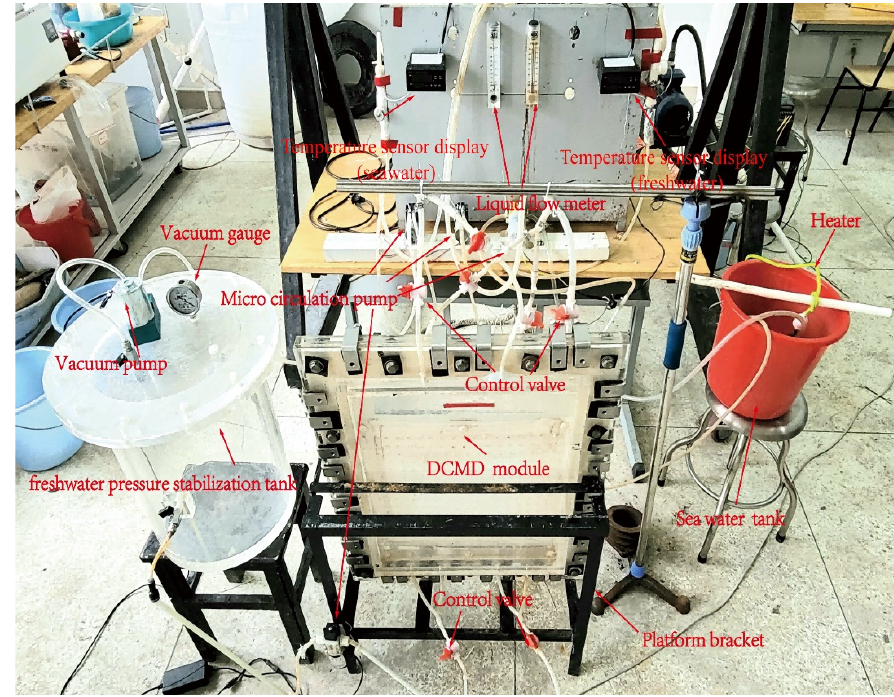
Figure 4. Testing platform for the VEDCMD seawater desalination.